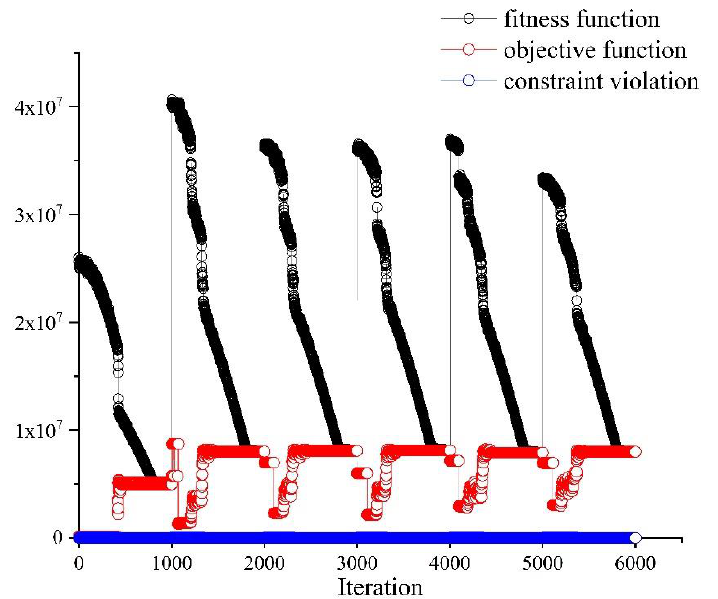
Figure 8. Convergence curves of fitness function, objective function, and constraint violation.